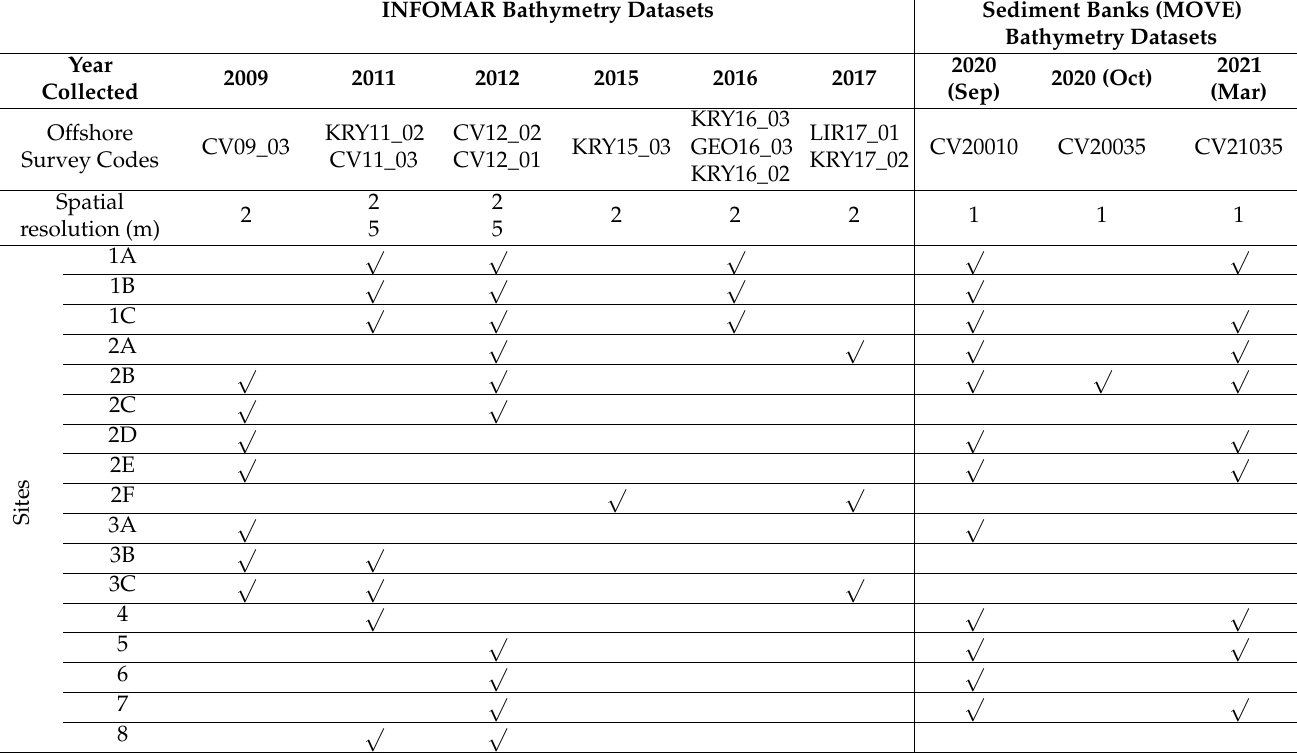
Table 2. Details of MBES bathymetry datasets used in this study. Location of each site is presented in Figure